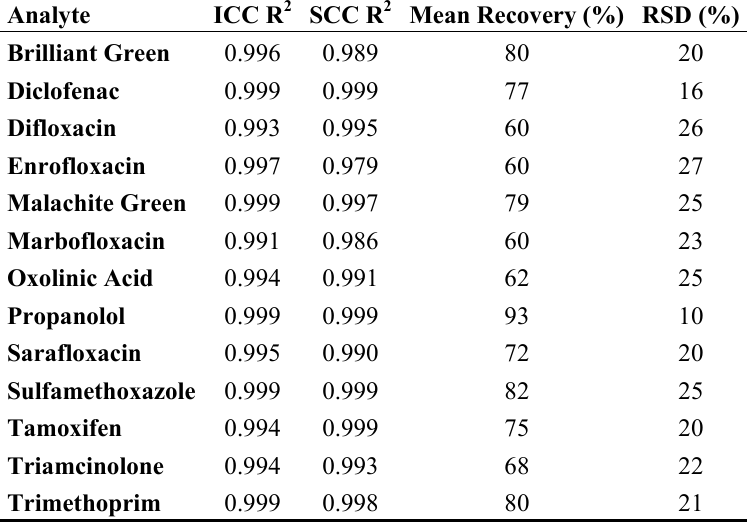
Table 5. Regression coefficients ( R 2 ), mean recoveries and relative standard deviation (RSD) of the selected veterinary